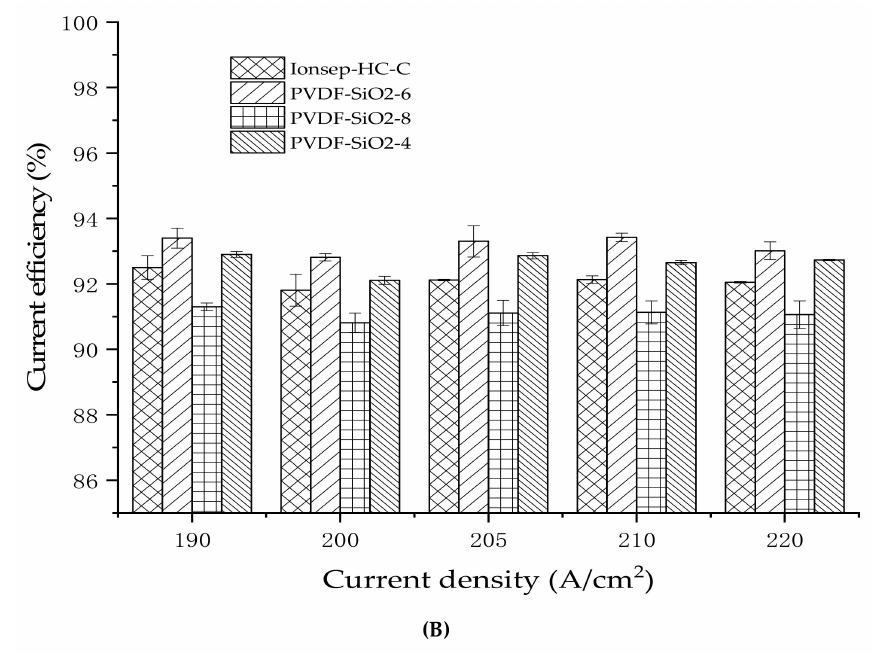
Figure 12. ( A ) Graph of the co-production of the four membranes as a function of the current density; ( B ) The relationship between the current e ffi ciency and current density in the cobalt recovery